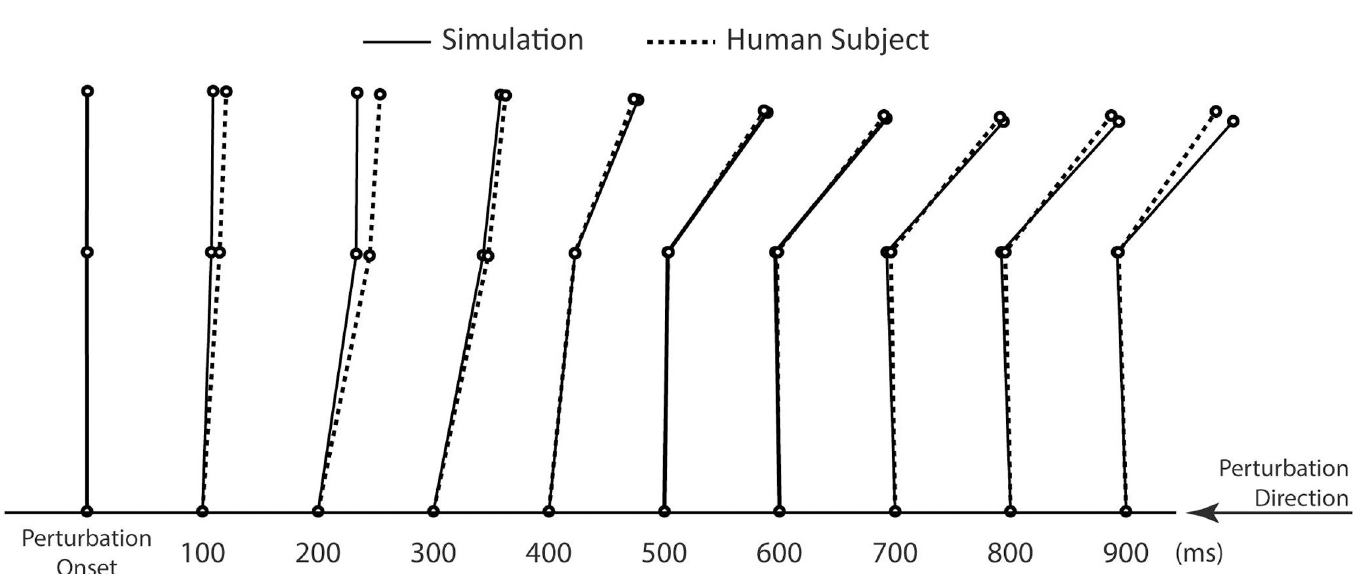
Fig 4. Comparison of body position between the human subject and simulation during the maximal platform displacement trial of the young model.